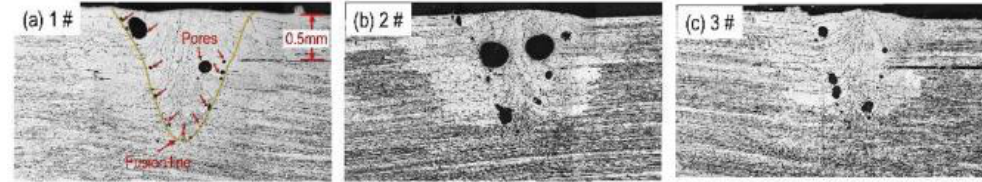
Figure 3. Typical porosity morphology in Mo joints produced by laser welding: ( a ) orthogonal experiment 1# parameter sample, ( b ) orthogonal experiment 2# parameter sample, and ( c ) orthogonal experiment 3# parameter sample. [11].